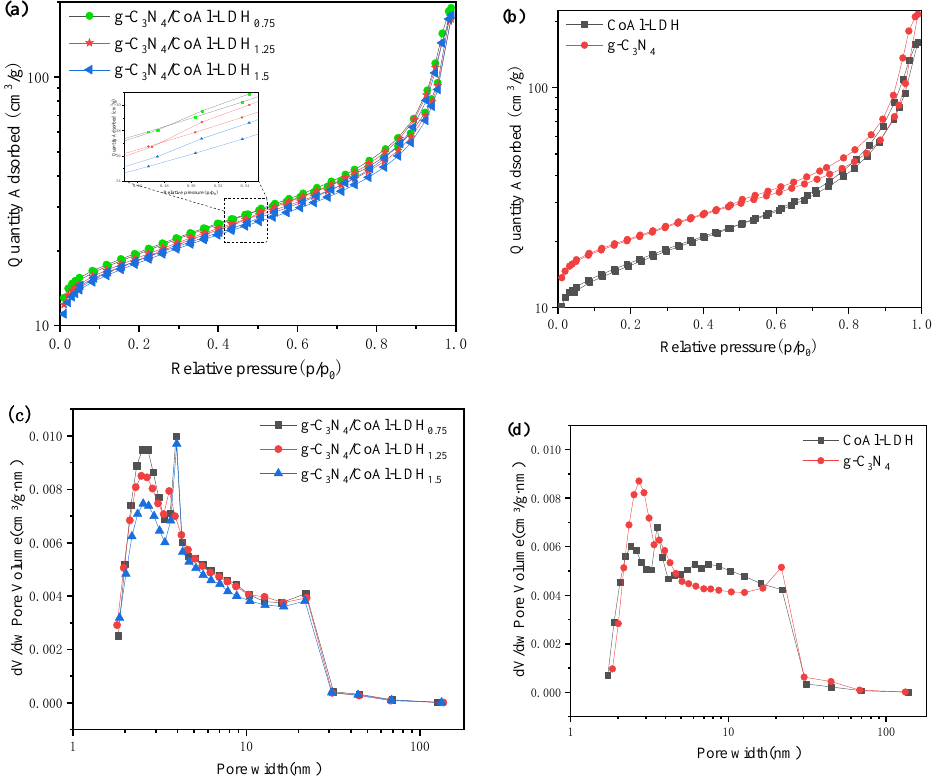
Figure 3. N 2 adsorption/desorption isotherms ( a , b ) and BJH pore size distribution ( c , d ) of g-C 3 N 4 , CoAl-LDH, and the g-C 3 N 4 /CoAl-LDH nanocomposites.